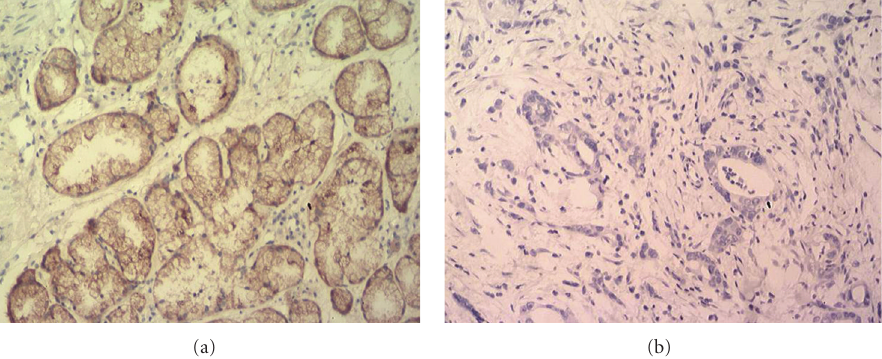
Figure 2: Immunohistochemistry to detect FAF1 protein. (a) Normal gastric mucosa tissue and (b) gastric cancer tissue from the same patient. FAF1 staining localized mainly to the nucleus and in some cases to the cell membrane. Magnification,